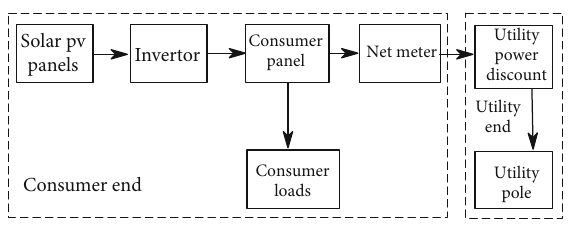
Figure 1: Block-diagram of net-metering mechanism [5]. Table 1: Pakistan all provinces solar irradiance